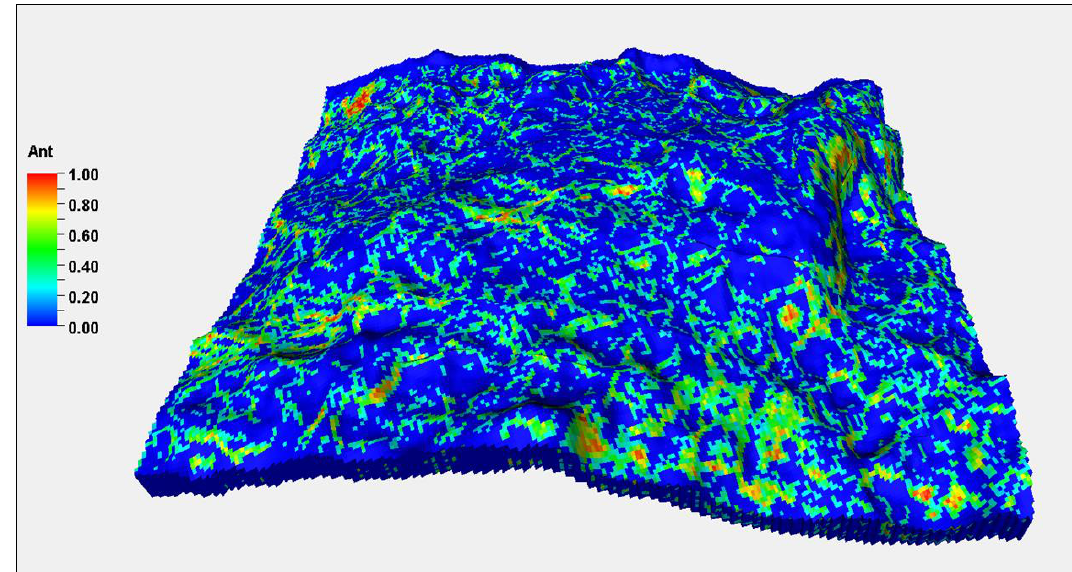
Figure 12. Ant track distribution model of B-P gas field.